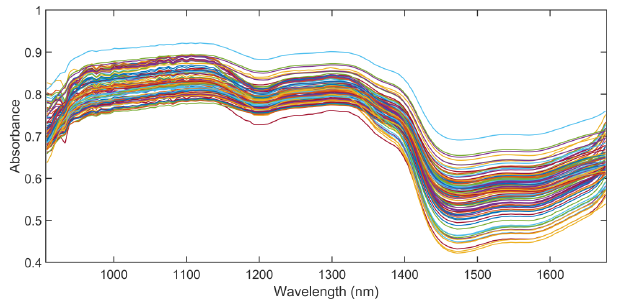
Fig. 2. Raw spectra of C. pilosula samples.